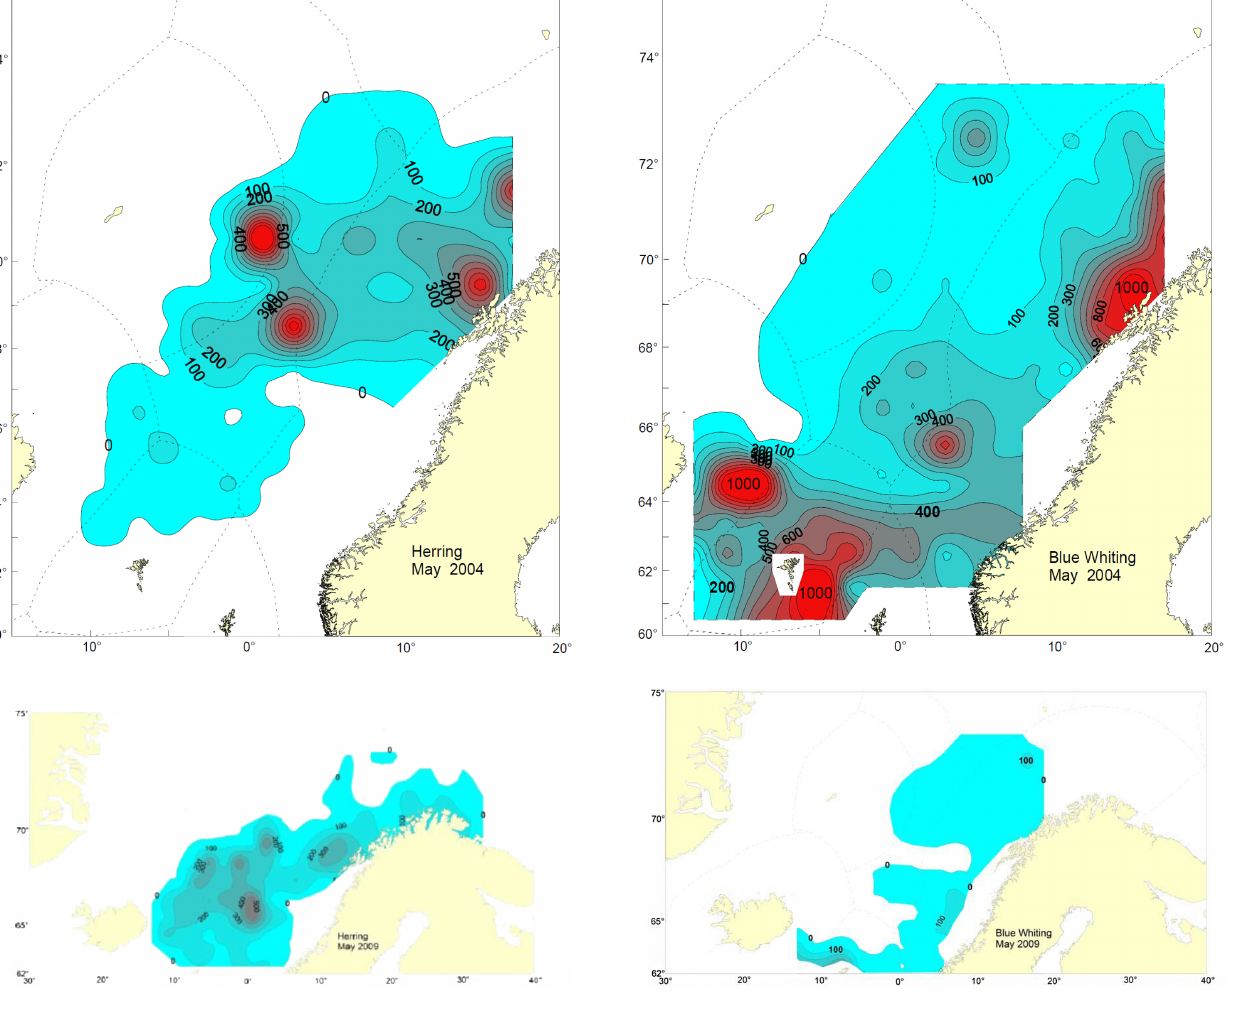
Figure 7. Distribution of blue whiting as measured during the IESNS in April–June 2004 (upper) and 2009 (lower) in terms of NASC values based on combined 5nmi values. From ICES (2004) and ICES